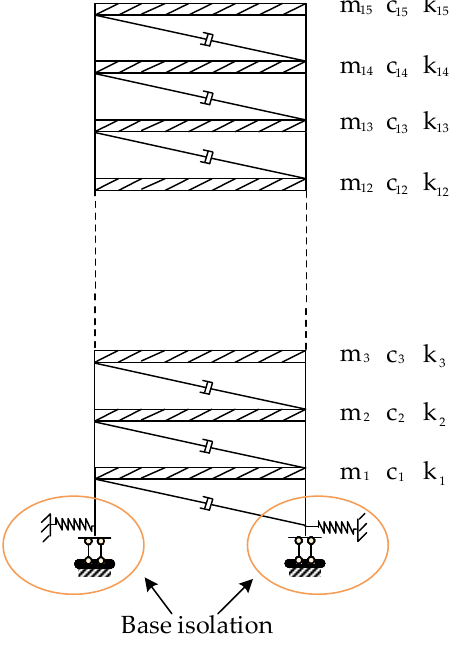
Figure 3. Fifteen-storey shear frame.